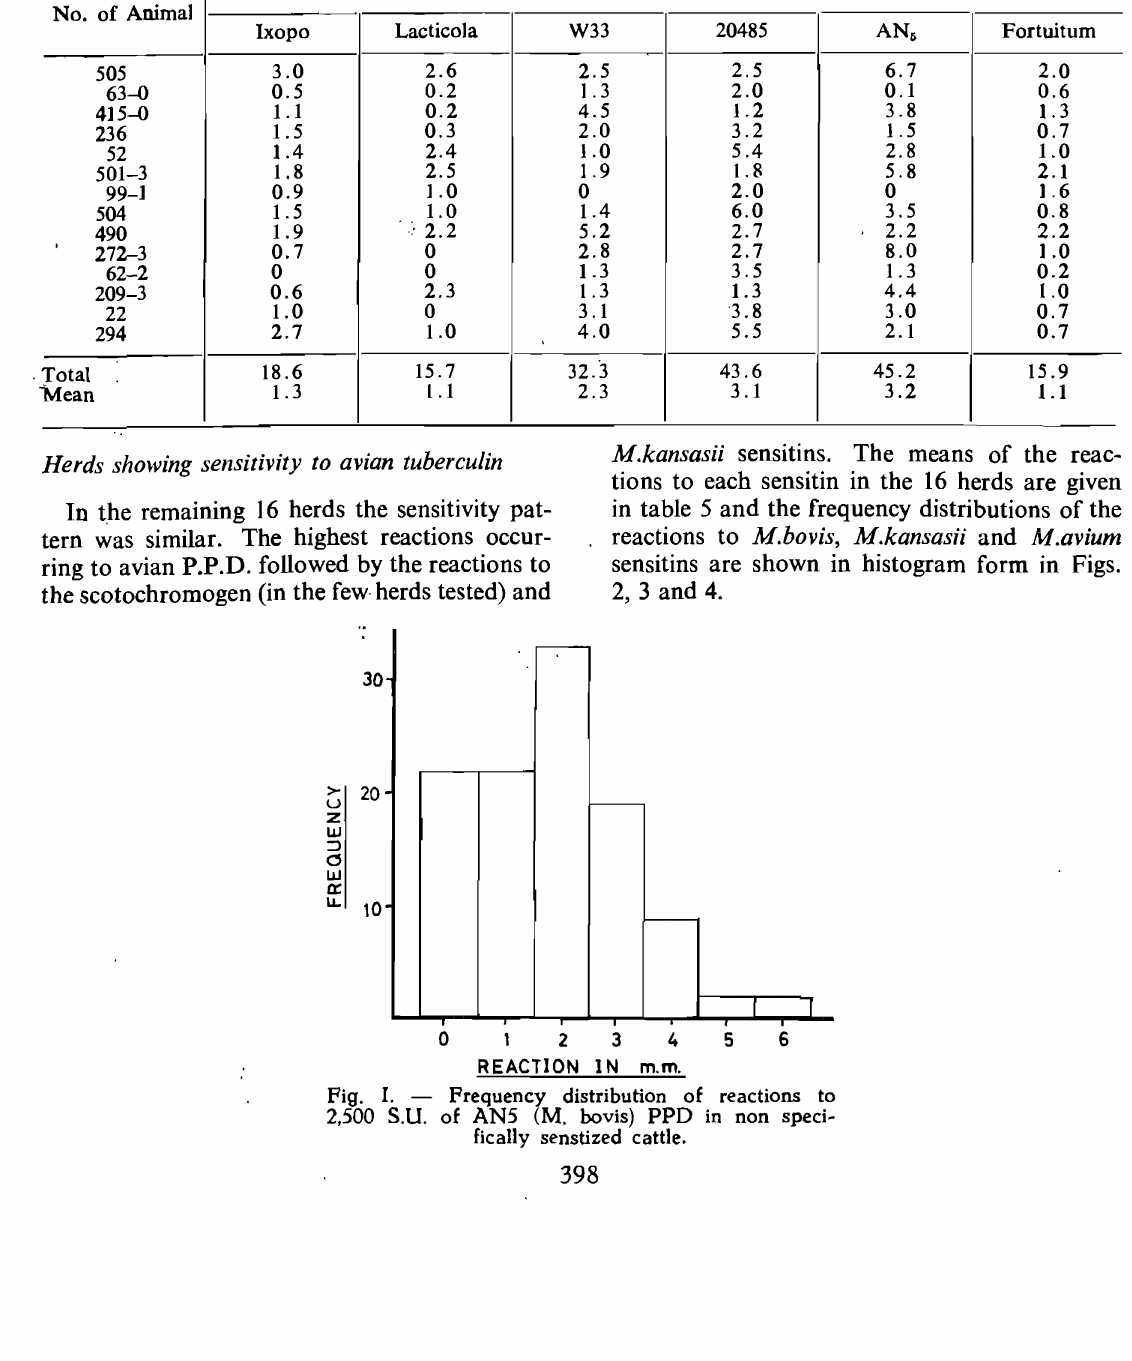
TABLE 4.-SKINFOLD INCREASES IN HERD VI. AT MULTIPLE COMPARATIVE TEST